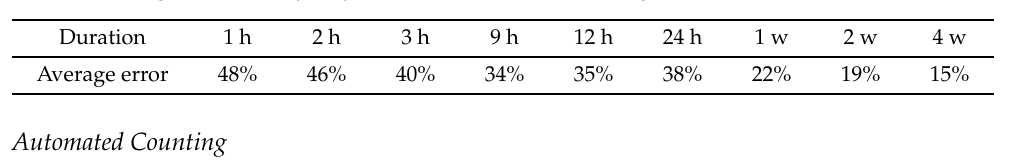
Table 1. Average annual daily bicycle estimation error according to